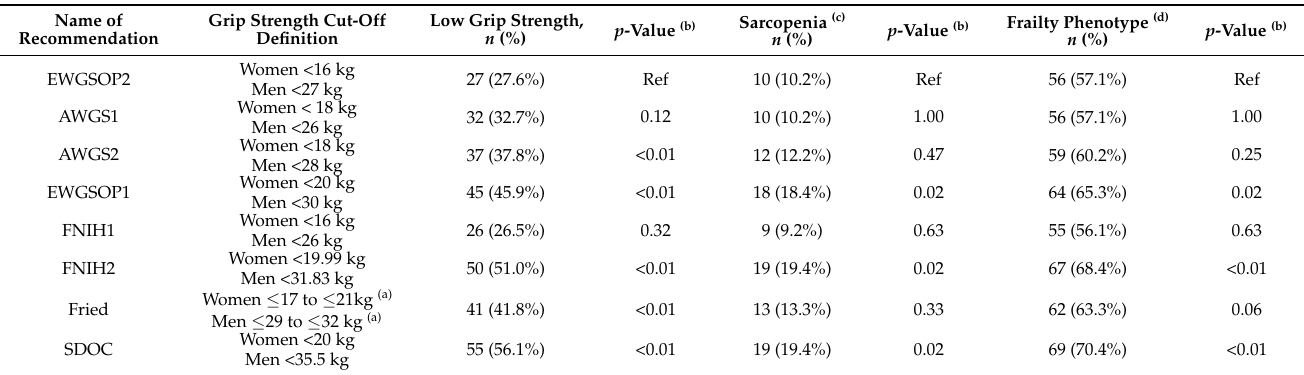
Table 3. Prevalence of low grip strength, sarcopenia, and frailty phenotype based on EWGSOP2 cut-off definition of low grip strength compared with other cut-off definitions of low grip strength ( n = 98).